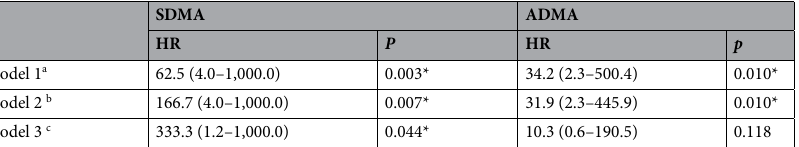
Table 3. Stepwise multivariable-adjusted regression analysis for SDMA and ADMA with in-hospital mortality. a Model 1 was adjusted for age and sex. b Model 2 was adjusted for age, sex, and eGFR. c Model 3 was adjusted for age, sex, eGFR, C-reactive protein, and pro-calcitonin. *denotes statistically significant associations with in-hospital mortality.